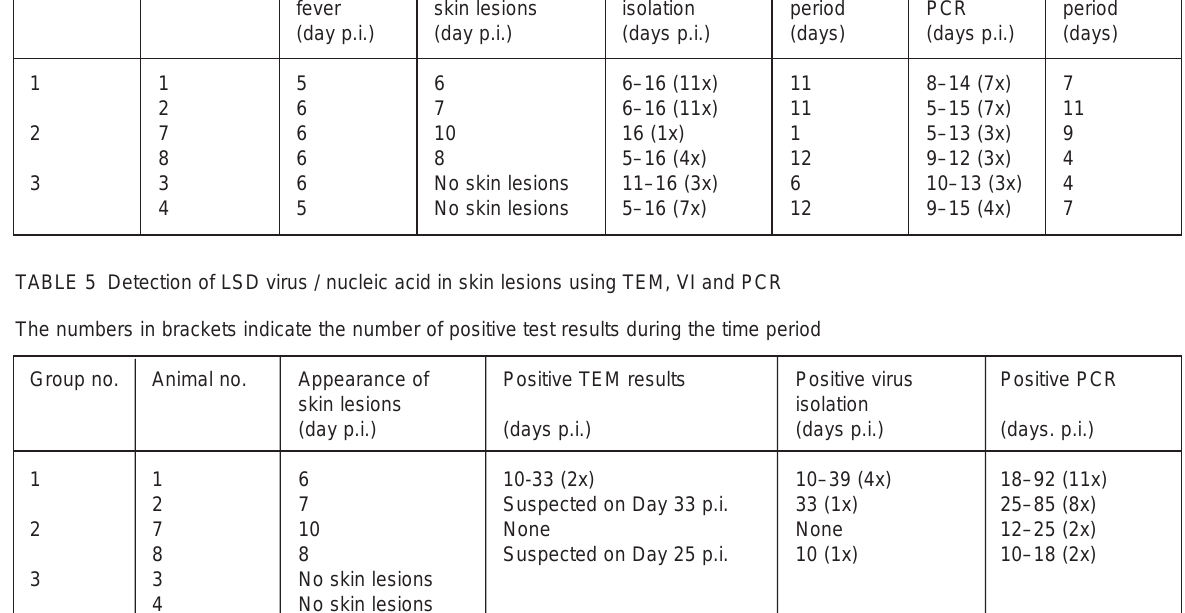
TABLE 4 The temperature reaction and the appearance of skin lesions relative to virus isolation and PCR results of blood samples. The numbers in brackets indicate the number of positive test results during the time period Group no.